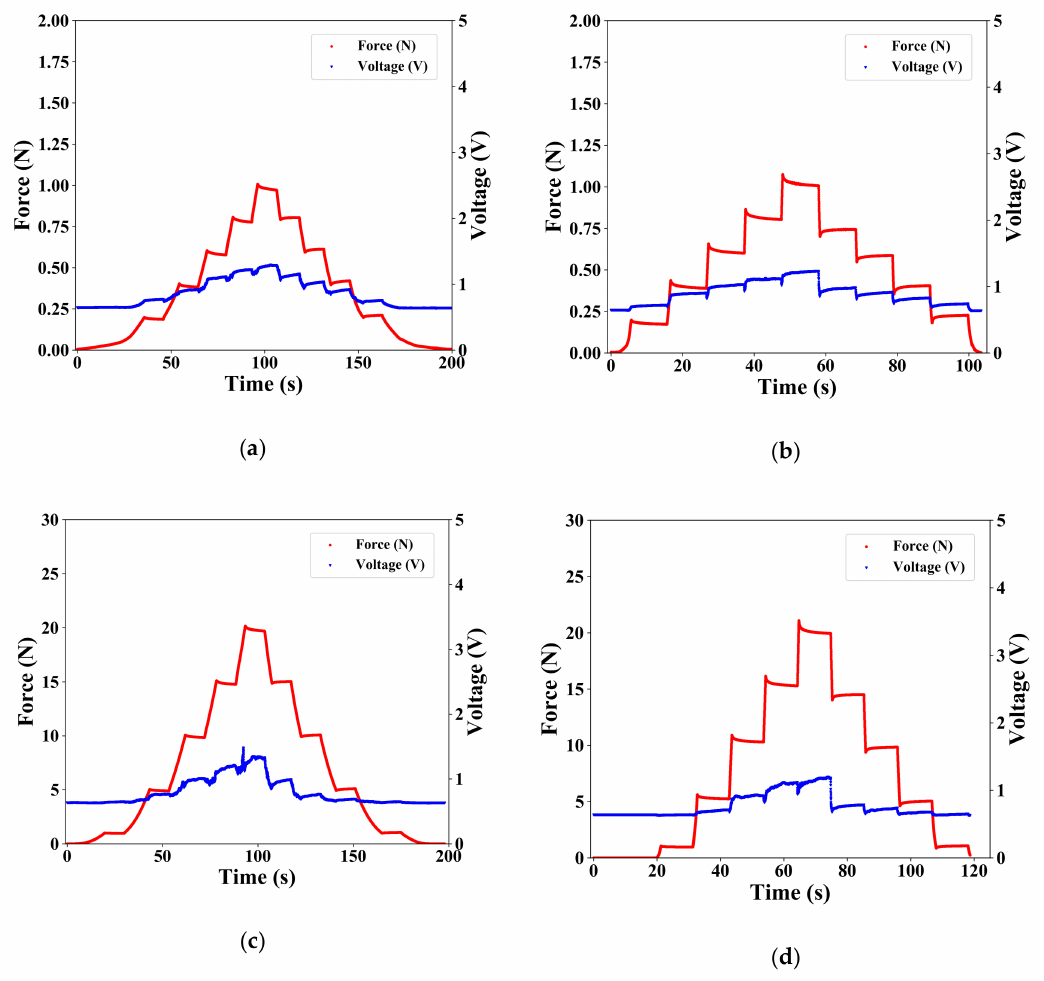
Figure 6. Results of the response for force-maintained input: ( a , b ) soft-MPS (soft) and ( c , d ) soft-MPS (hard) at testing rates of ( a , c ) 1 mm / s and ( b , d ) 10 mm /